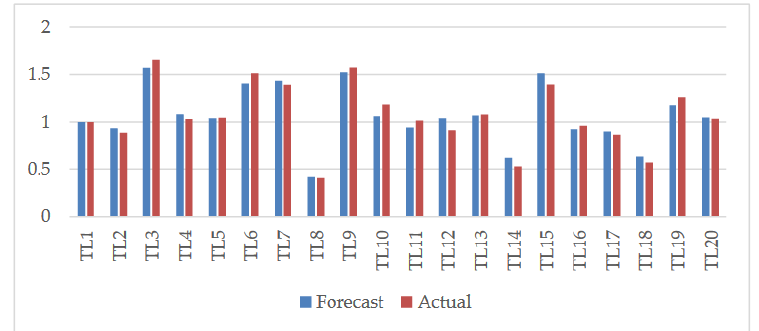
Figure 4. Forecast score and actual 2019 scores (Thailand). Mathematics 2020 , 8 , x FOR PEER REVIEW